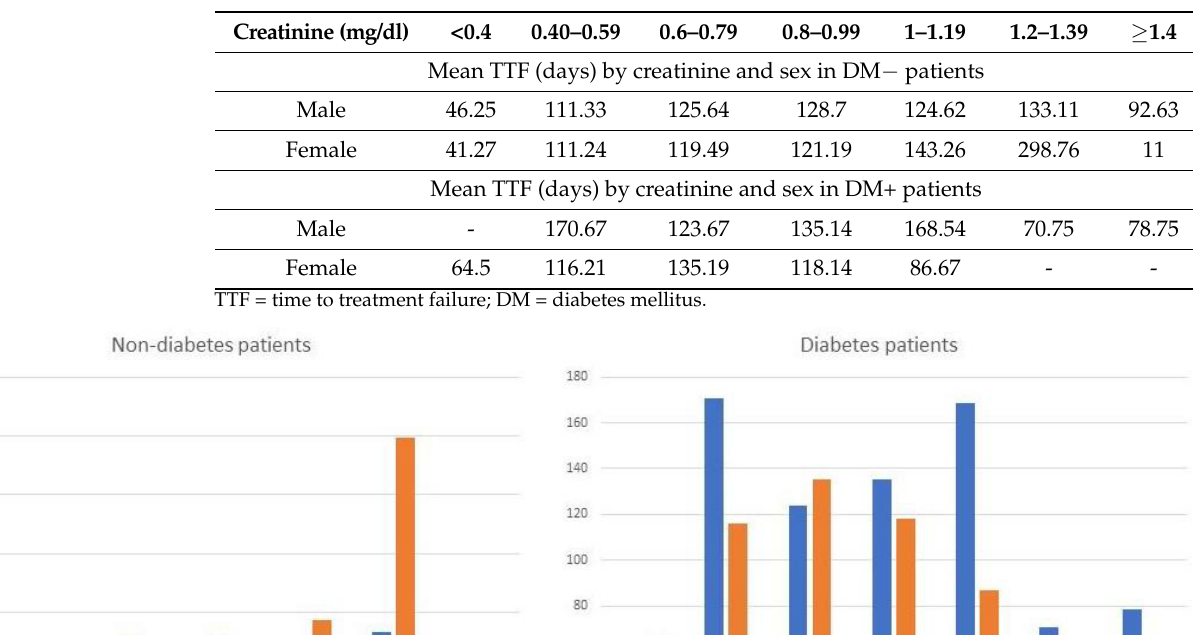
Table 4. Average TTF by creatinine and gender in patients with and without DM.